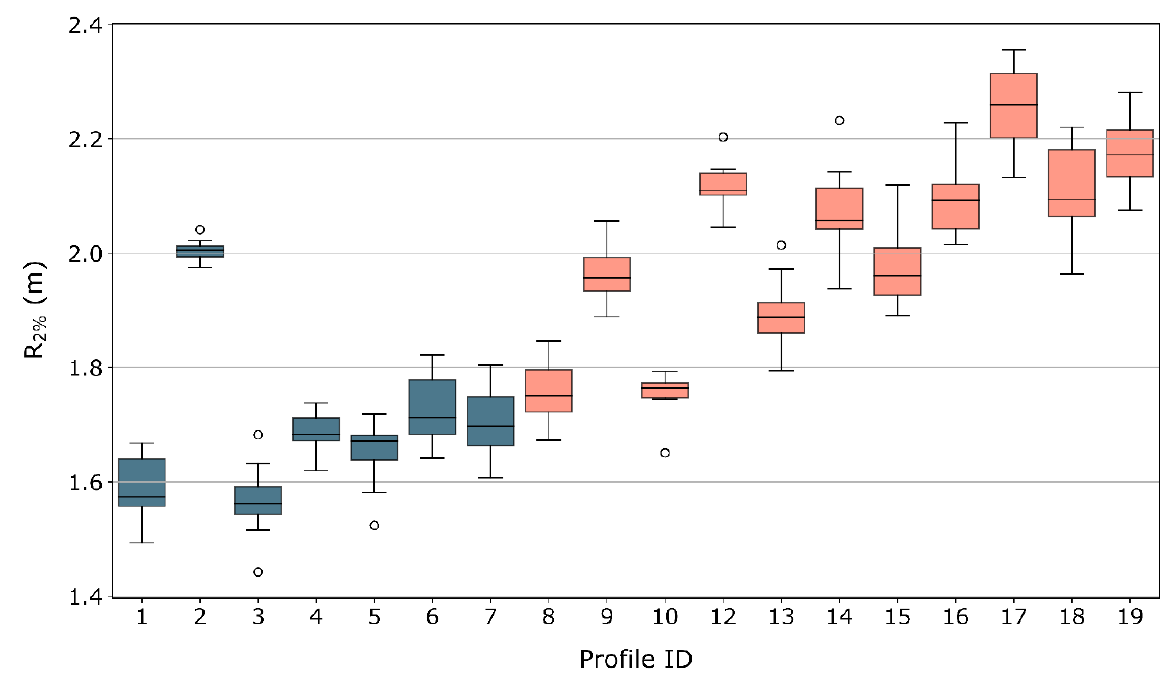
Figure 8. Run-up magnitude (m) measured as R 2% plotted for each representative profile. Box plots represent the distribution of R 2% values which arise from the 10 model runs performed for each representative profile. Blue and orange shading of boxes indicates that the profile originates from the unmanaged and managed sections of the BPBS, respectively. Profile 11 has been omitted from this figure because the observed morphological change (breaching) following the December 2013 storm surge could not be simulated.